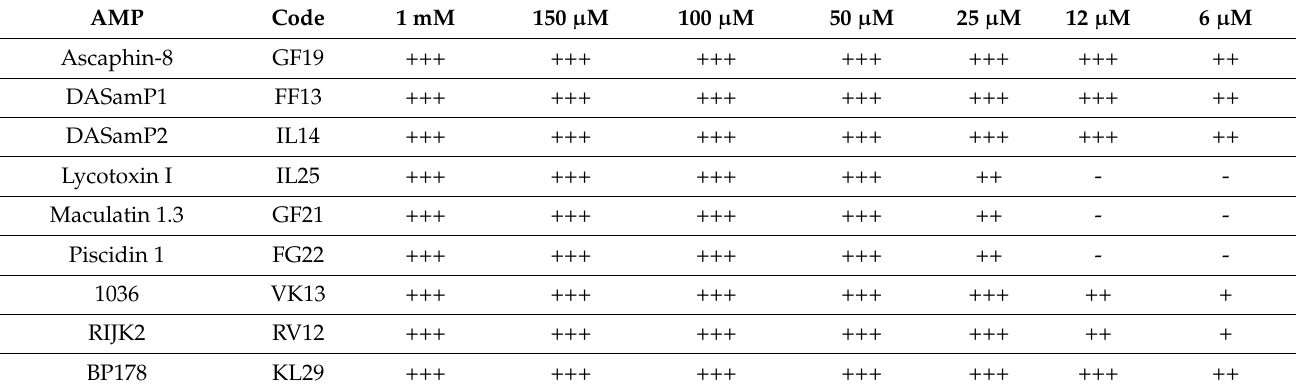
Table 2. Effect of AMPs on growth inhibition of Xanthomonas albilineans.